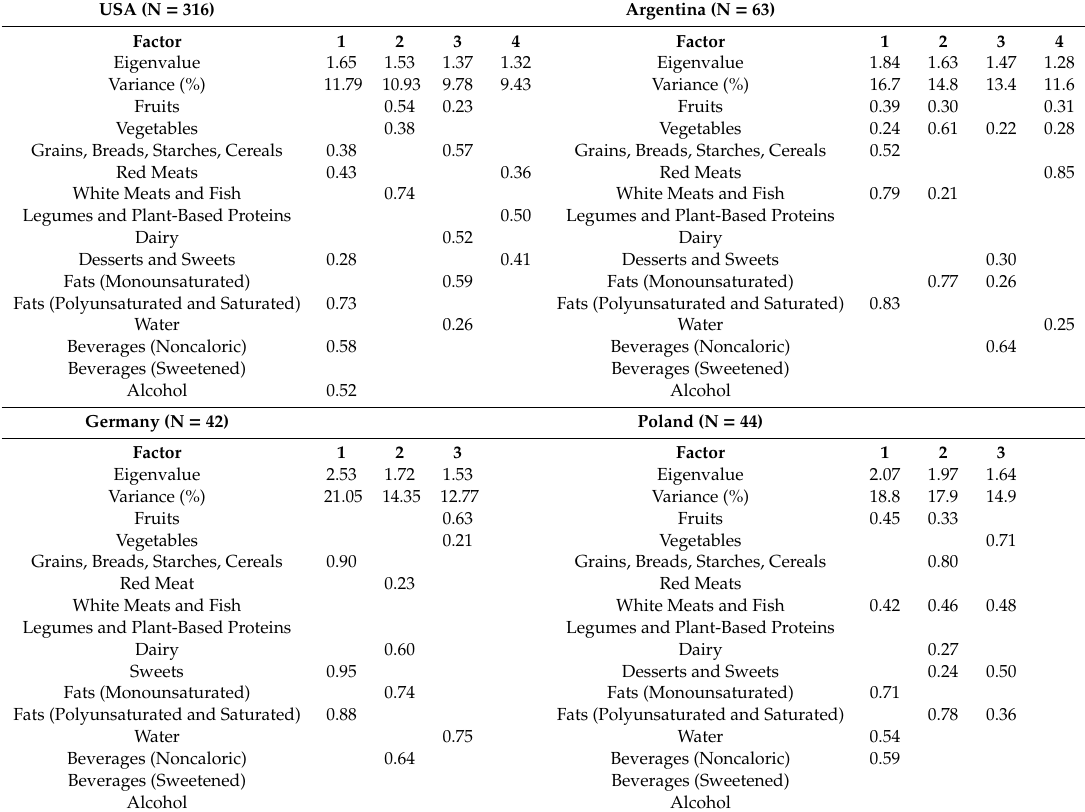
Table 2. Results from Principle Components Factor Analysis of Dietary Intakes from Adults with Type 2 Diabetes From Nine